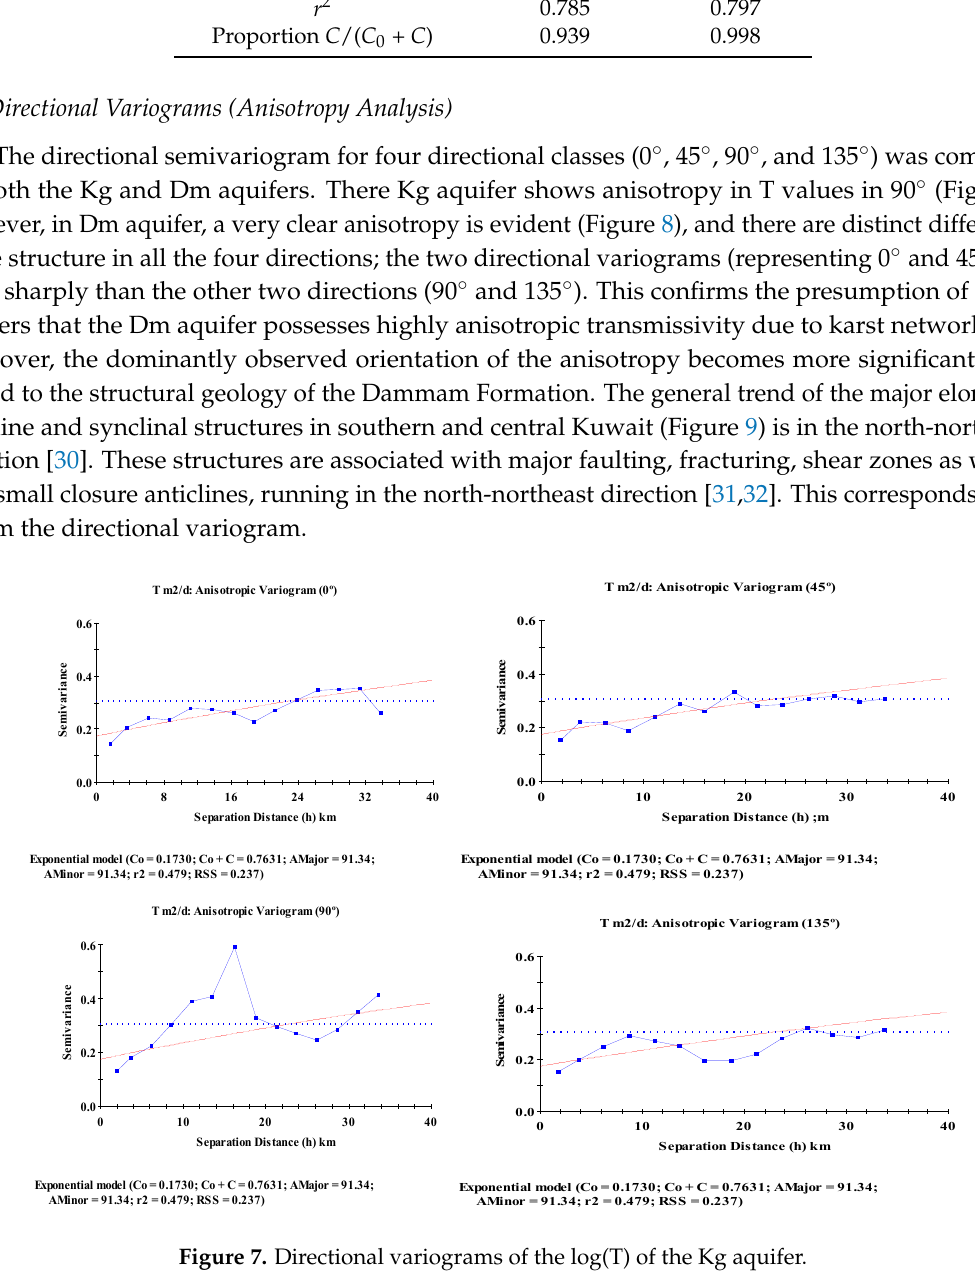
Table 2. Fitted parameters for model semivariogram.